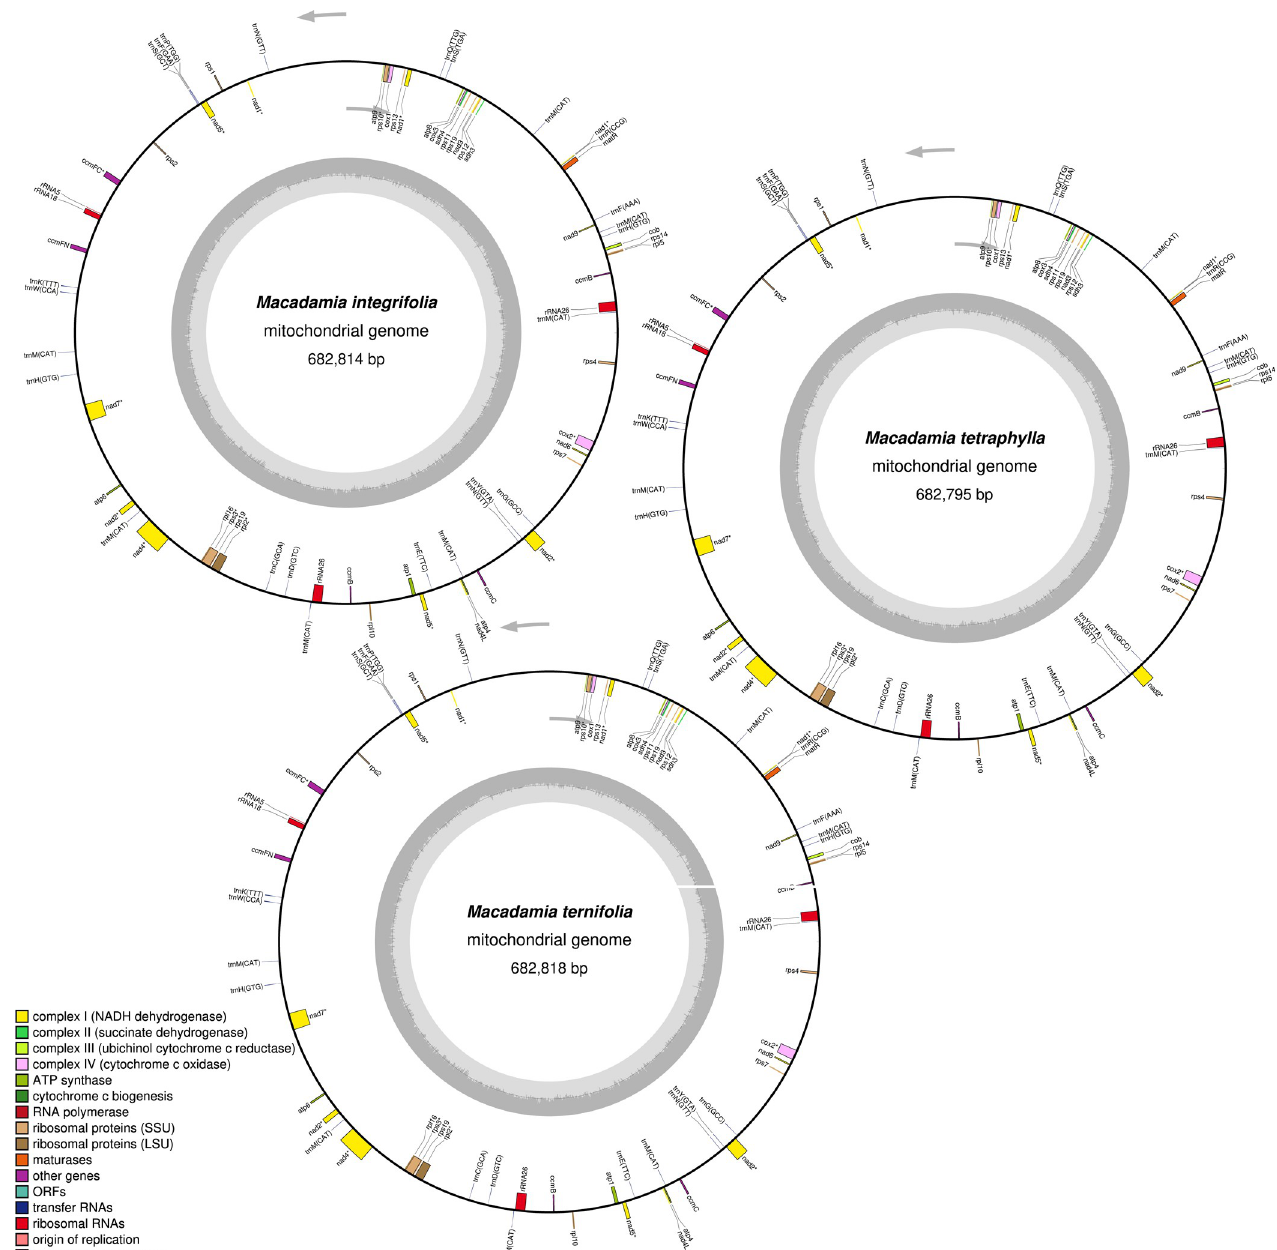
Fig 1. The circular map of three Macadamia species mitochondrial genome. Gene map showing 71 annotated genes of different functional groups.